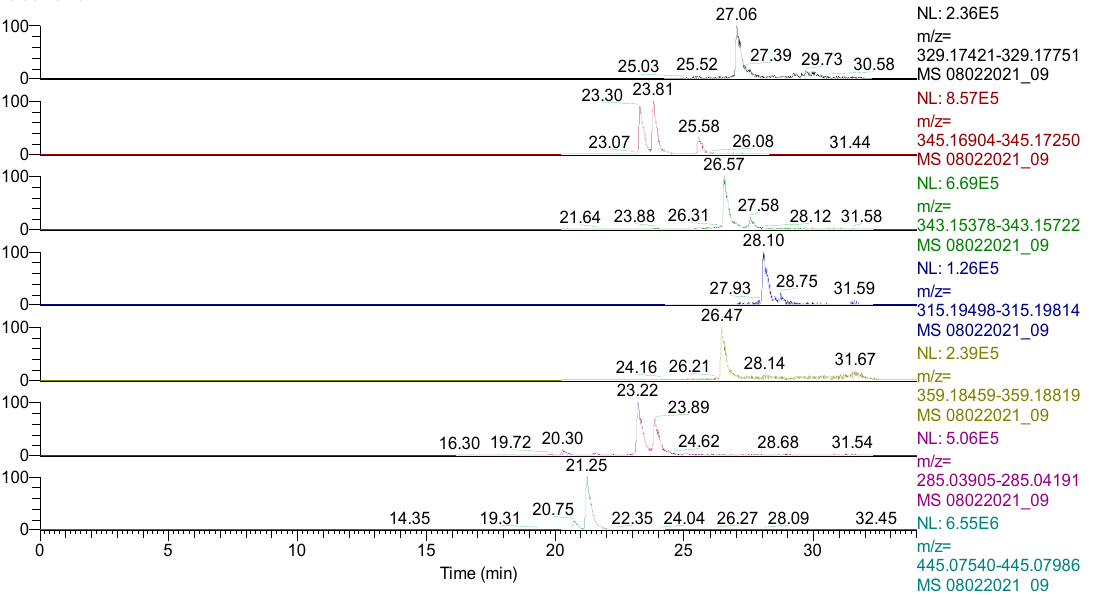
Figure 7. UHPLC–HRMS/MS chromatogram for AE in which were identified (top to bottom): carnosol ( m/z : 329.17585, Rt: 27.06), rosmanol/epirosmanol ( m/z : 345.17077, Rt: 23.07/23.81), rosmadial ( m/z : 343.15509, Rt: 26.57), rosmaridiphenol ( m/z : 315.19656, Rt: 28.10), rosmanol methyl ether ( m/z : 359.18639, Rt: 26.47), luteolin ( m/z : 285.04048, Rt: 23.22/23.89), and apigenin-7-O- glucuronide ( m/z : 445.07763, Rt: 21.25).